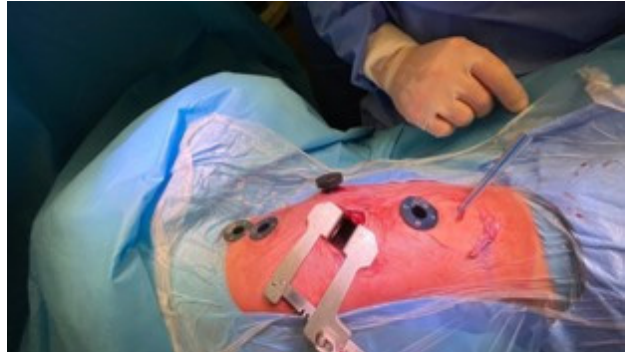
Figure 3. Incisions and position of the instruments: a small muscle-sparing thoracic incision is performed at the eighth intercostal space. Three 5-mm ports on the anterior axillary line between the fourth and the eighth intercostal spaces are inserted, at the same level as the vertebral defects as confirmed by fluoroscopy; one 10-mm port for a 30° camera is placed medially to the minithoracotomy.